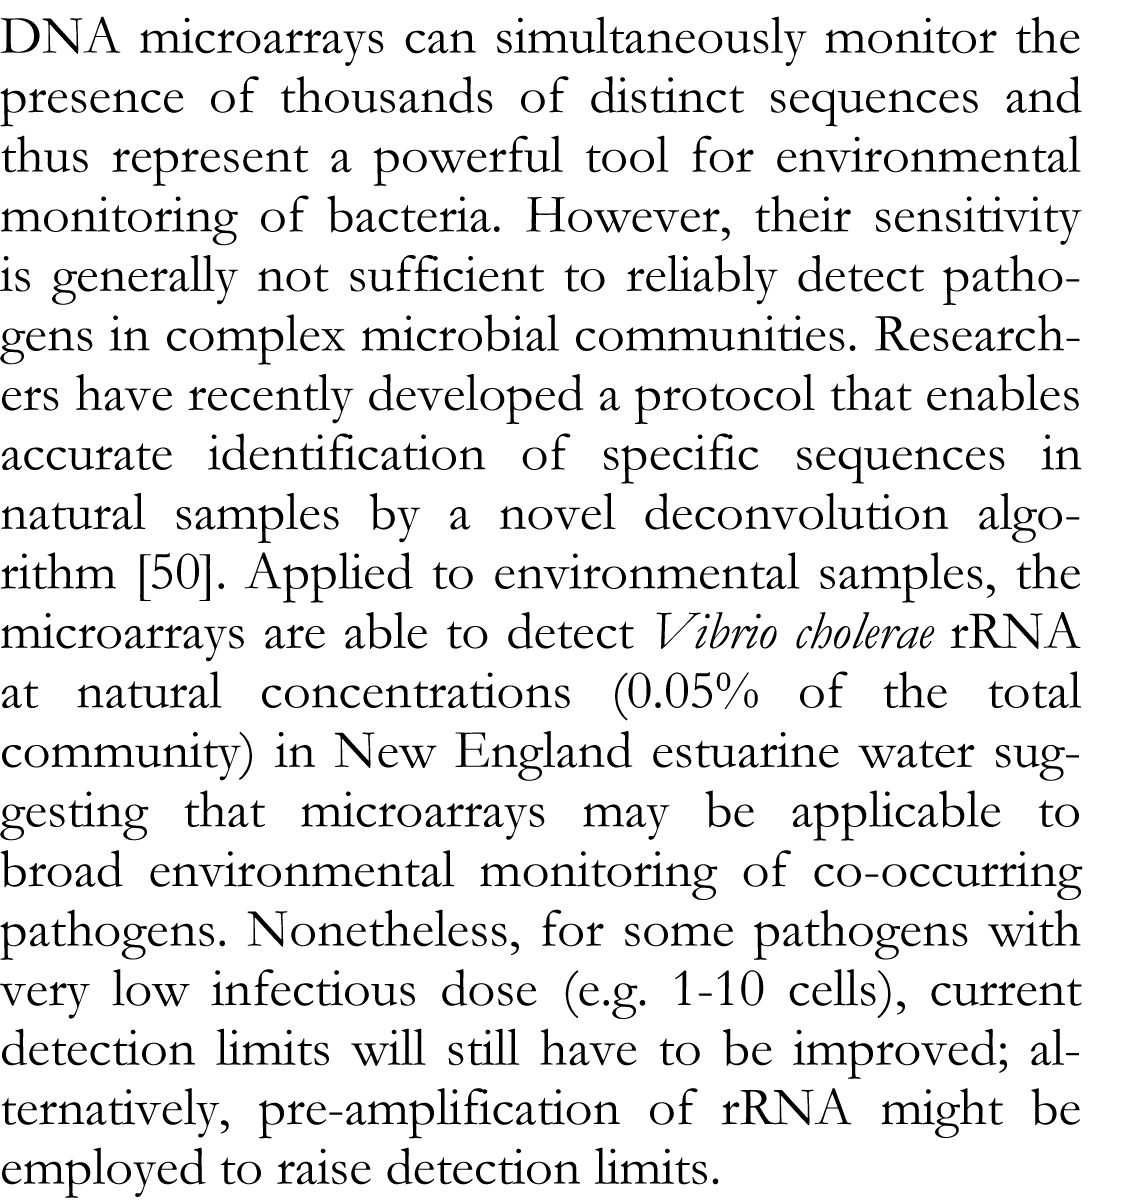
Pushing the limits of DNA microarrays. Reference [50].